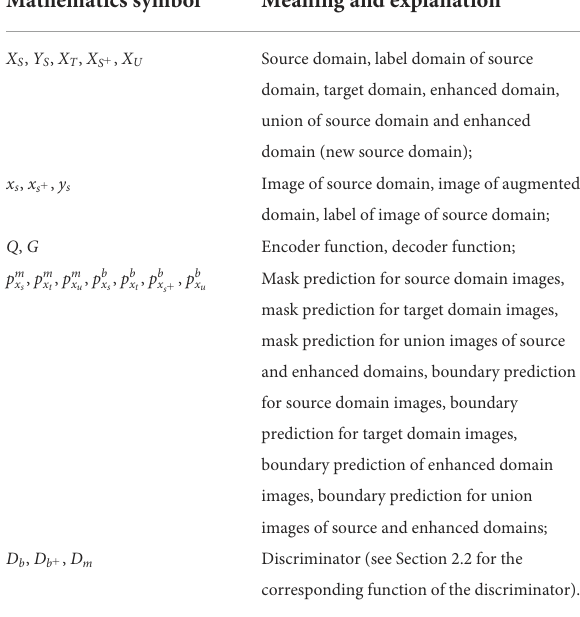
TABLE 1 Mathematical function symbol comparison